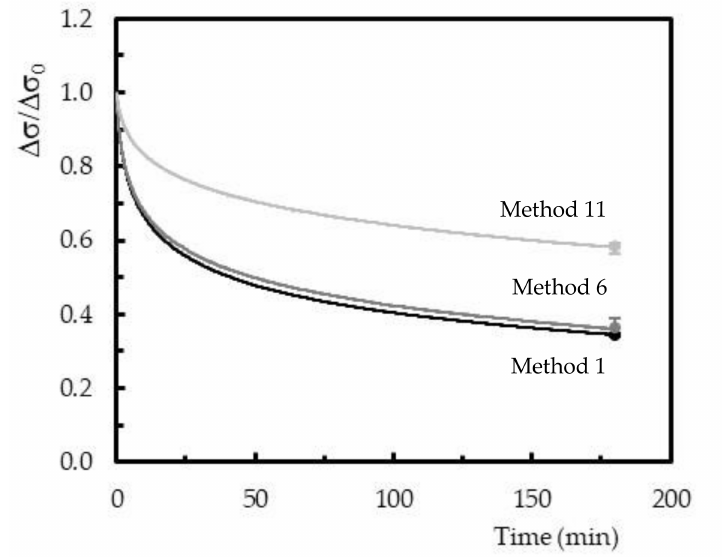
Figure 9. Stress relaxation curves obtained for the specimens 1, 6, and 11 (bending strain correspondent to 51.5